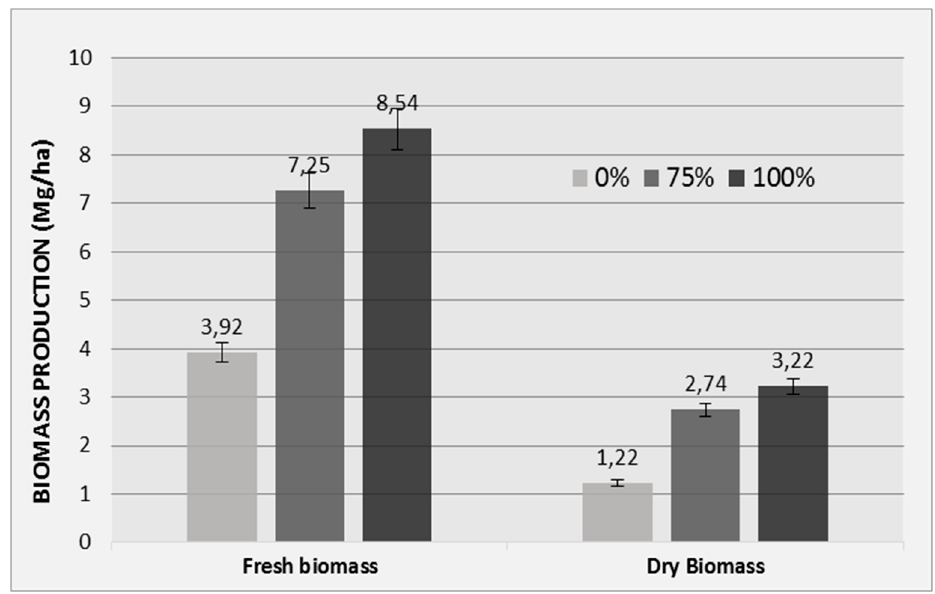
Figure 3. Fresh and dry biomass production in each